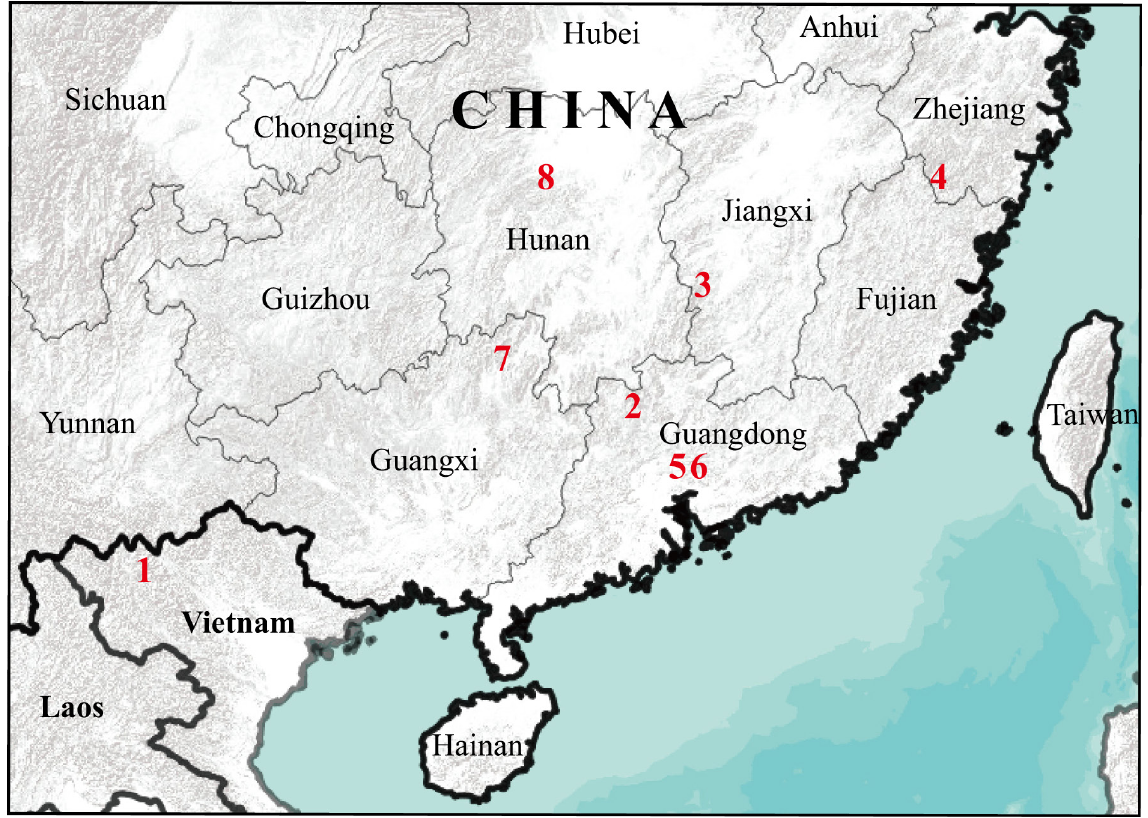
Fig. 6. Distribution of Vietomartyria spp. 1 = V. expeditionis (Mey, 1997); 2 = V. nanlingana Hirowatari & Jinbo, 2009; 3 = V. jinggangana (Yang, 1980); 4 = V. baishanzuna (Yang, 1995); 5 = V. nankunshana Hirowatari & Hashimoto, 2009; 6 = V. gladiator Hirowatari & Huang, 2010; 7 = V. maoershana sp. nov.; 8 = V. wuyunjiena sp.